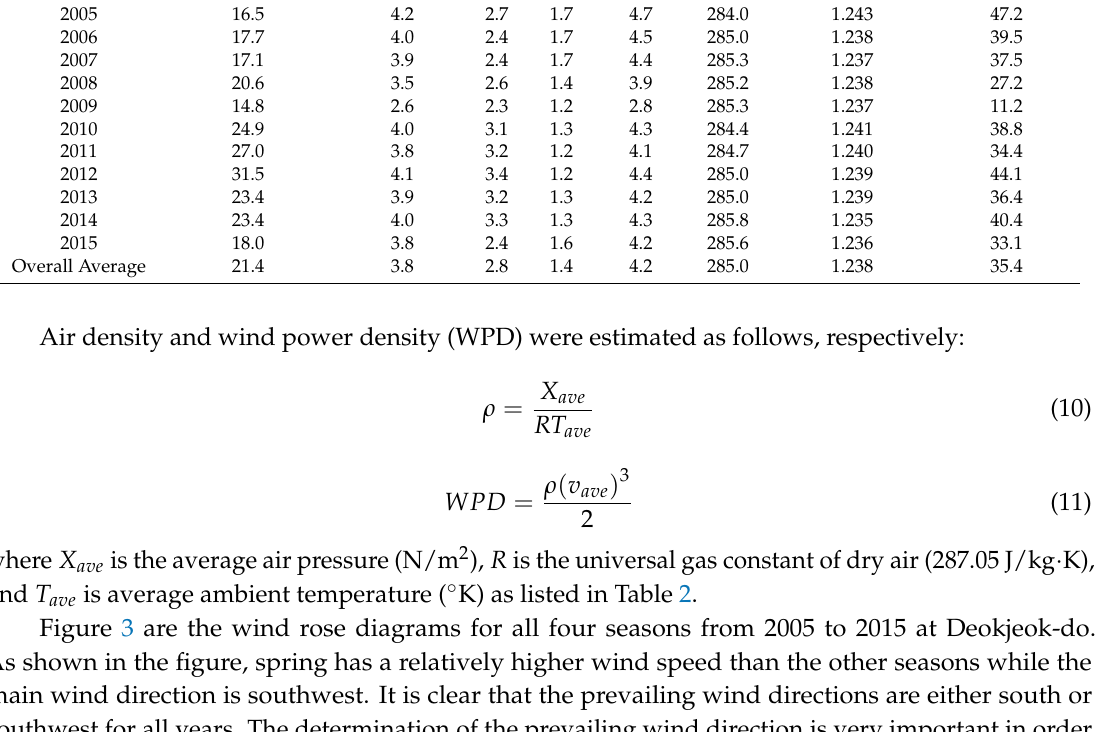
Table 2. Long term wind data analysis of Deokjeok-do at 10 m from local ground.